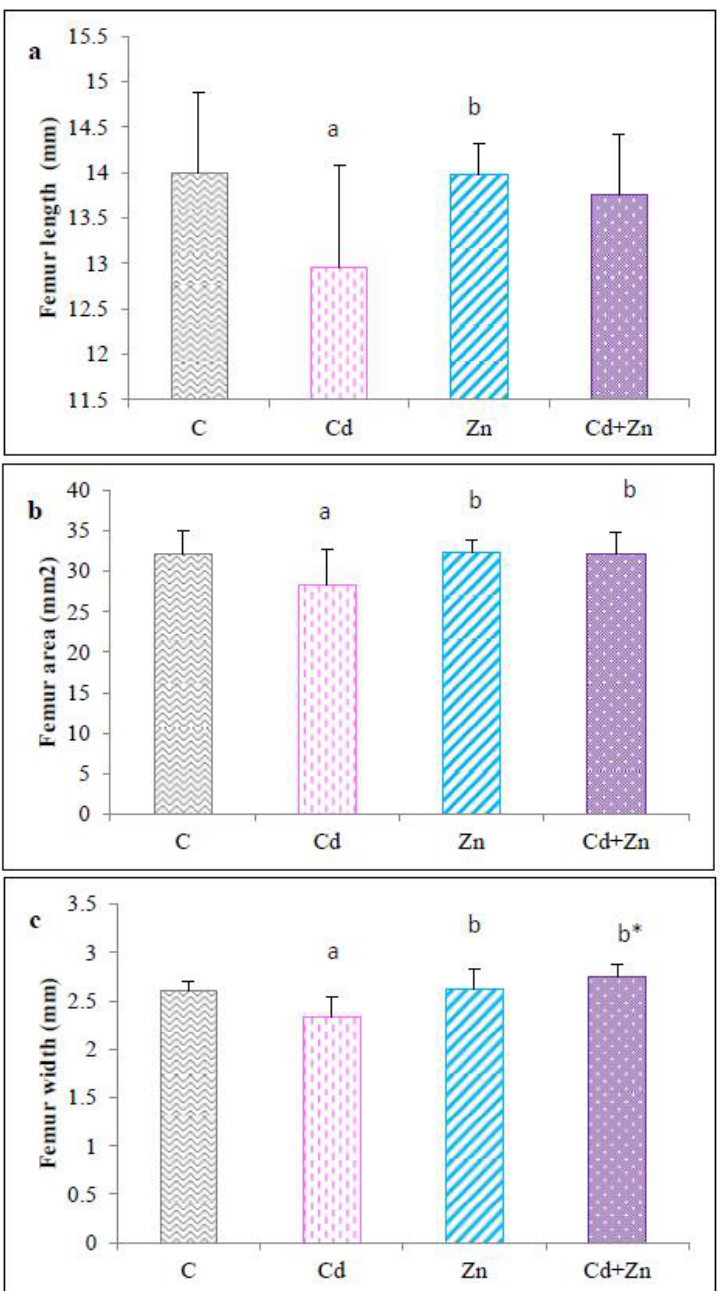
Figure 4. Femur length ( a ), femur area ( b ), and femur width ( c ) of rat pups (PND21) from control females and pups from females exposed to cadmium (50 mg/L Cd as CdCl2) and / or zinc (60 mg/L Zn as ZnCl2) during gestation and lactation. Means ± SEM from six samples in each groups; a ( p < 0.05): significant difference compared to the control group (C); b* ( p < 0.01); b ( p < 0.05):